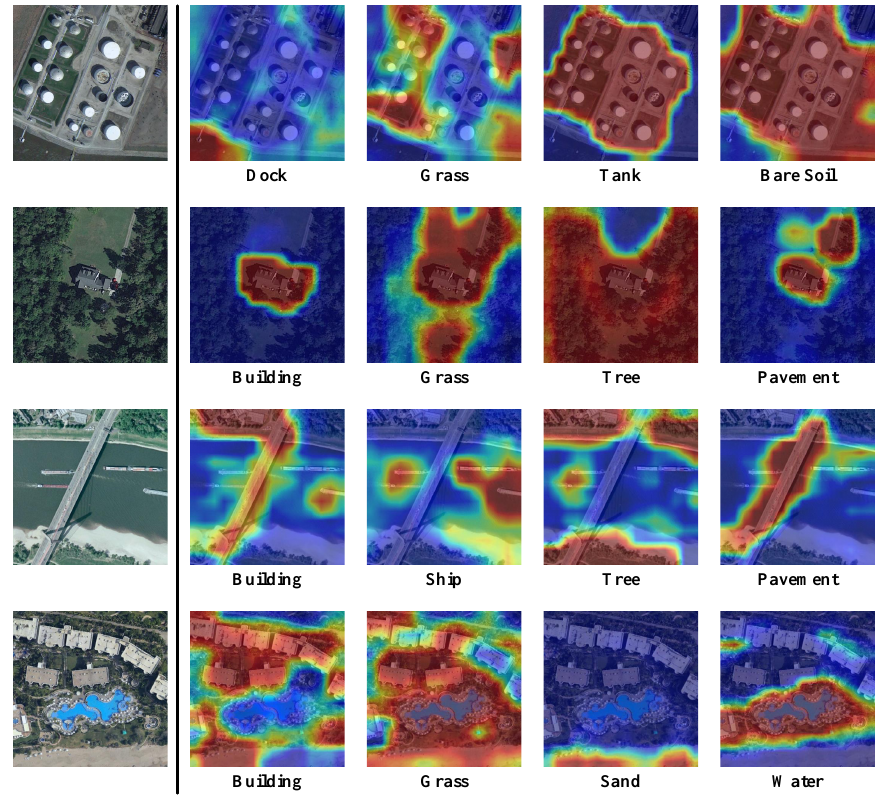
Figure 7. Visualization of the class-specific activation map in the SDM on the AID Multi-label